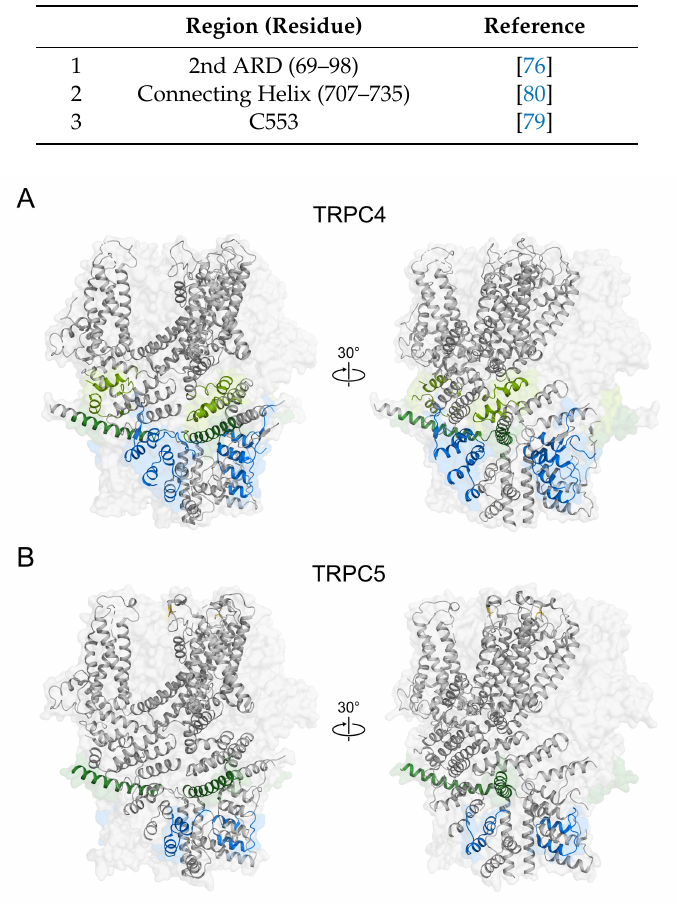
Figure 4. Domains responsible for tetramerization process in TRPC4 and TRPC5 channels. ( A ) Domains in TRPC4 channels. Blue domains : ARD; Light green domains : HLH; Green domains : connecting helix. ( B ) Domains in TRPC5 channels. Blue domains : ARD; Green domains :